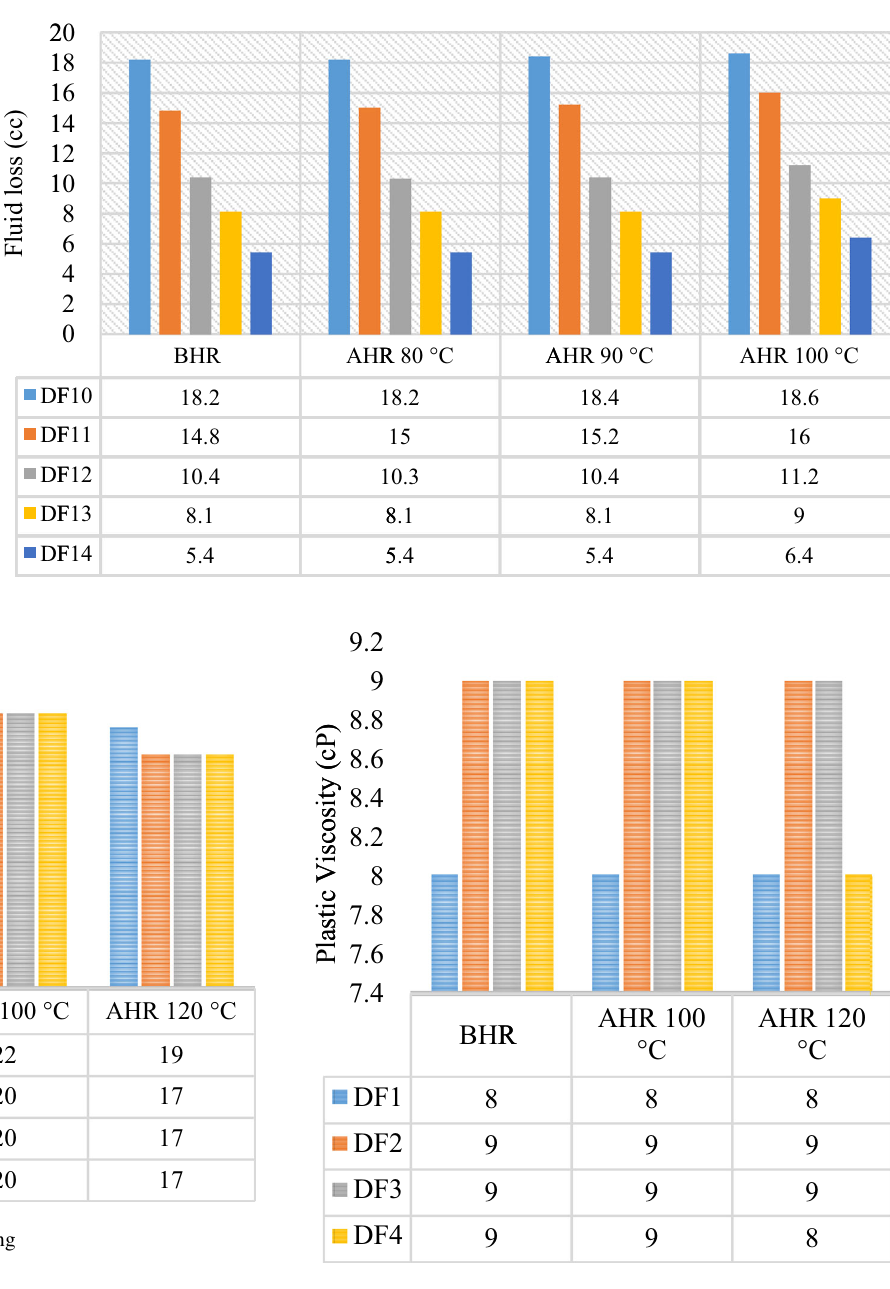
Fig. 8 Variation of PV after hot